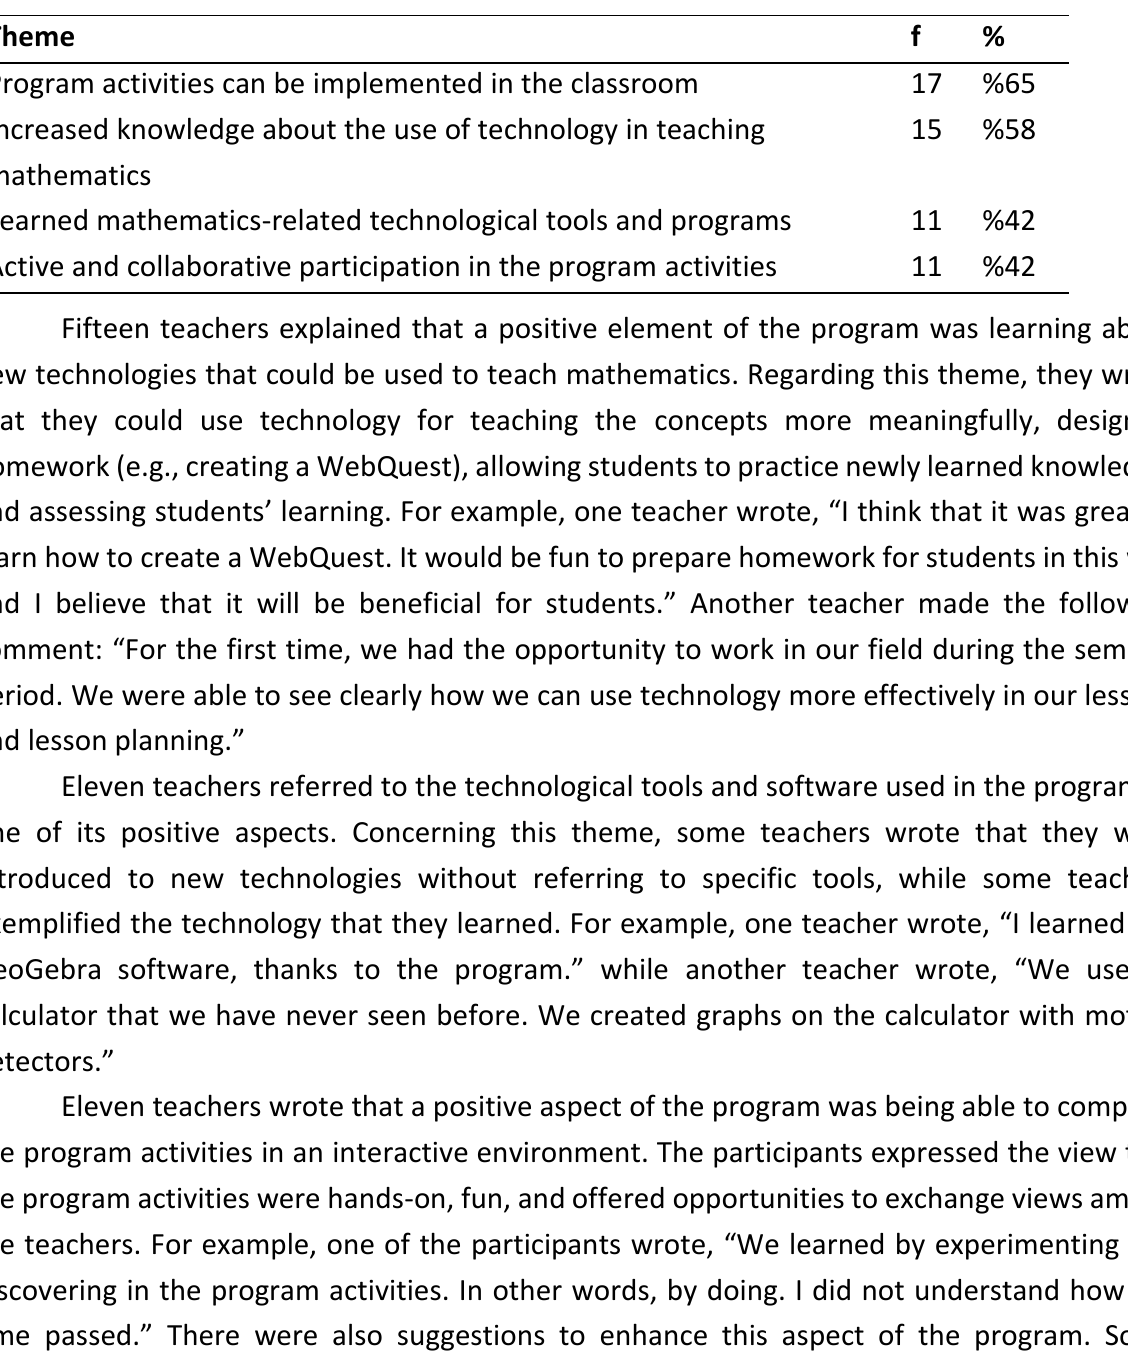
Table 5. Positive Elements of the Program According to the